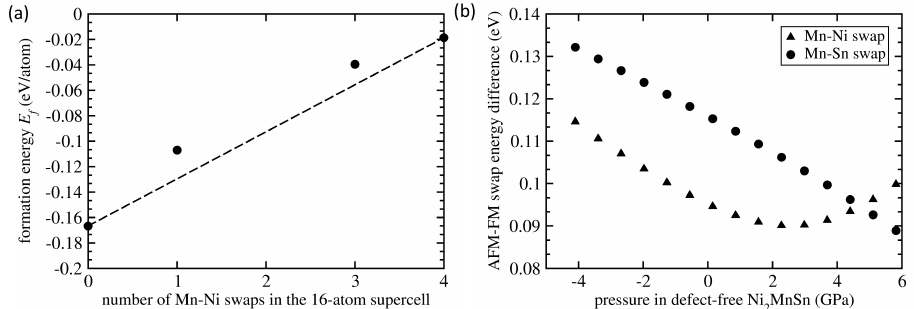
Figure 9. Computed compositional dependence of formation energy of systems with Mn-Ni swaps as a function of their number in 16-atom supercells modeling stoichiometric Ni 2 MnSn ( a ). Part ( b ) shows a pressure-dependence of the energy difference between AFM and FM-coupled